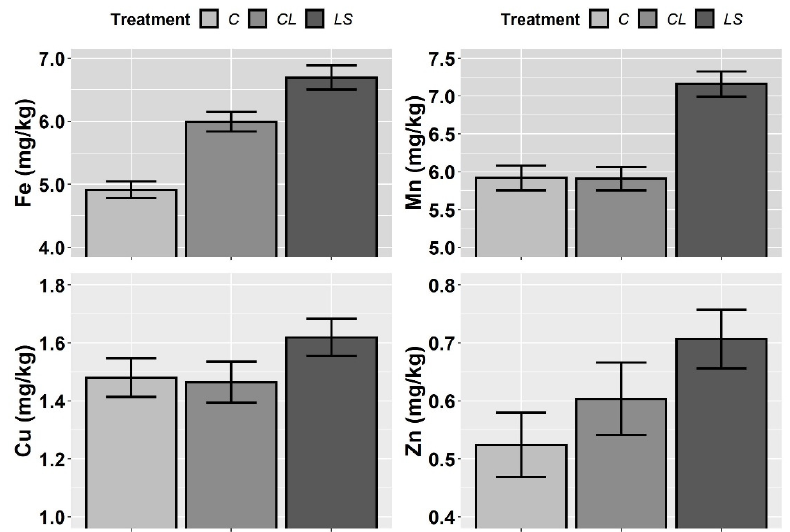
Figure 2. Mean values of the soil parameters iron (Fe), manganese (Mn), copper (Cu) and zinc (Zn) for each treatment. Treatments: control (C), control of leonardite (CL), and leonardite mixed with ferrous sulphate heptahydrate (LS). Error bars reflect the SE of the mean (±1 SE mean).